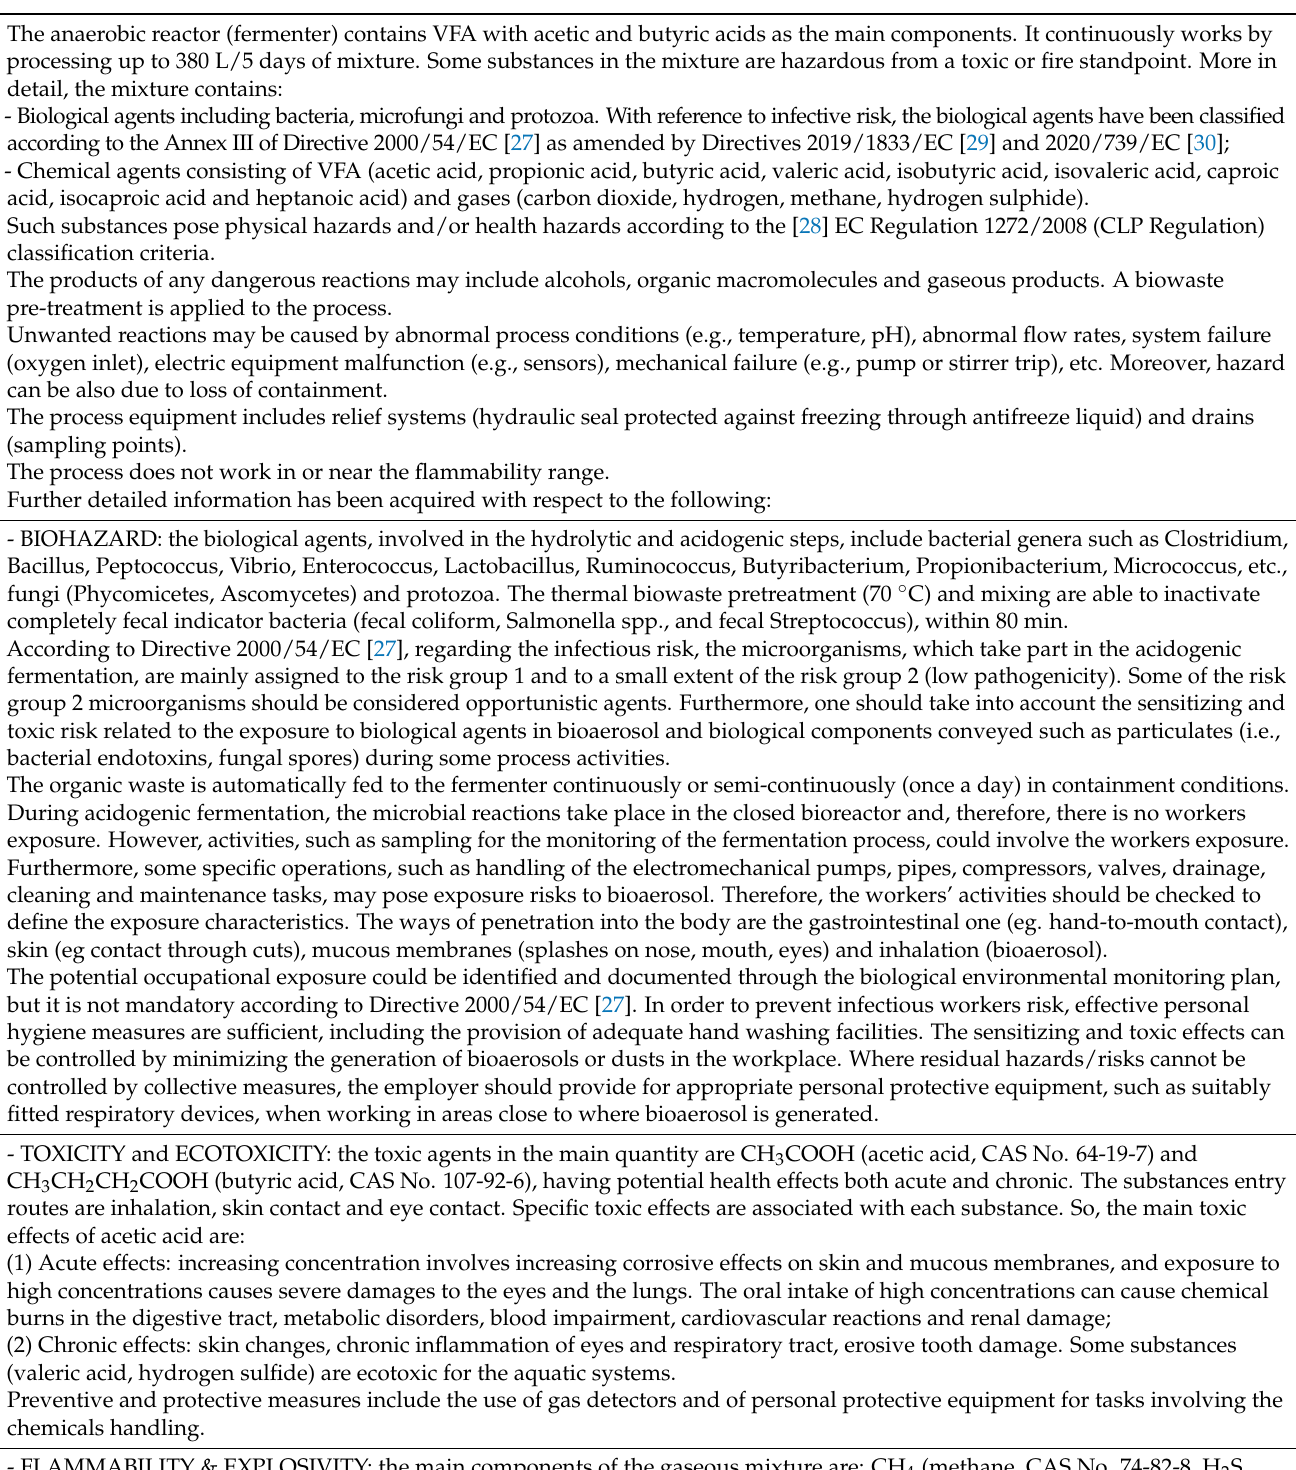
Table 4. Node 1: CSTR (collection of useful information for BioHazOp